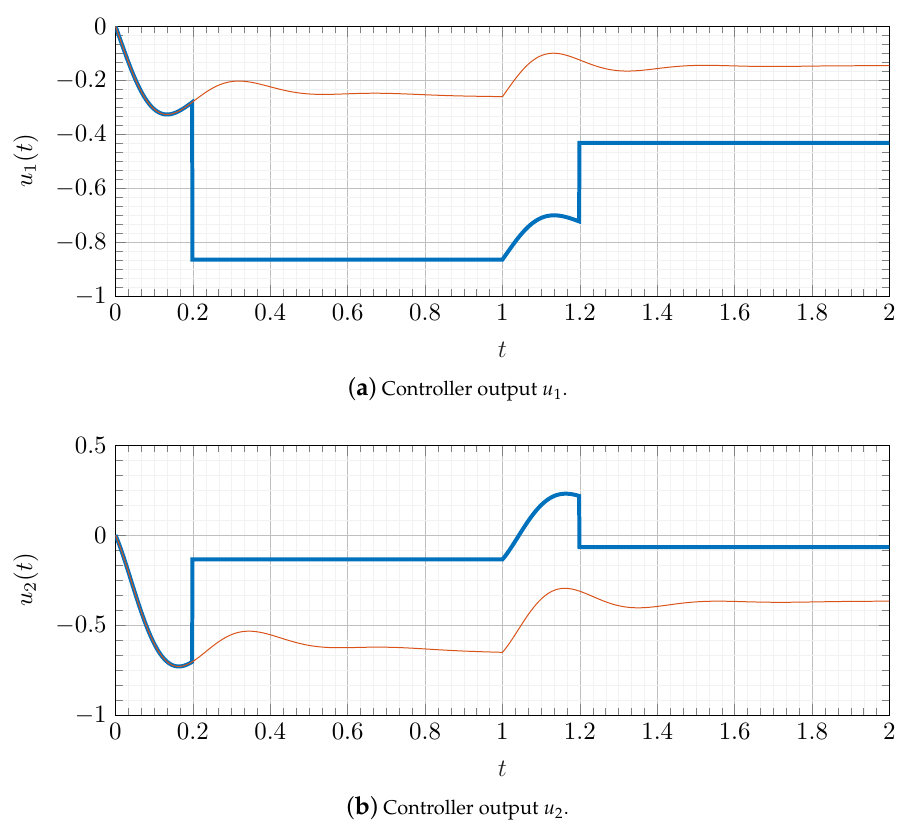
Figure 8. Controller outputs for the disturbance rejection example: (orange thin line) base PI controllers; (blue thick line) PI + CI